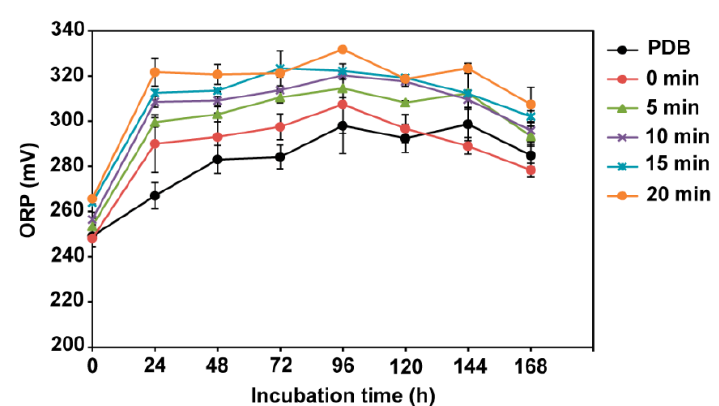
Figure 5. Oxidation reduction potential (ORP) measurements in the PDB media post plasma treatment for 5, 10, 15, and 20 min, or without treatment (0 min). Post plasma treatment, the fungal spores in the PDB solution were cultured for 168 h, and the ORP was measured every 24 h. Each value is indicated as the mean and standard deviation of 9 replicate measurements.